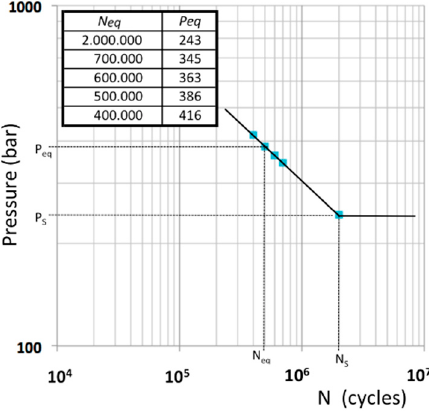
Figure 5. Laboratory test parameters according pressure specifications.